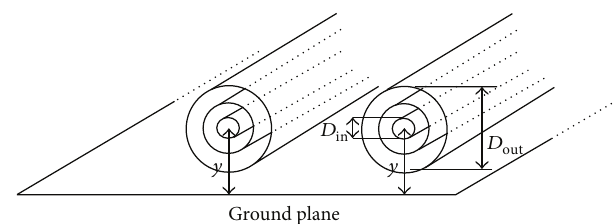
is not similar and this fact causes the coupling (intertalk) effects between neighboring shells to have a major